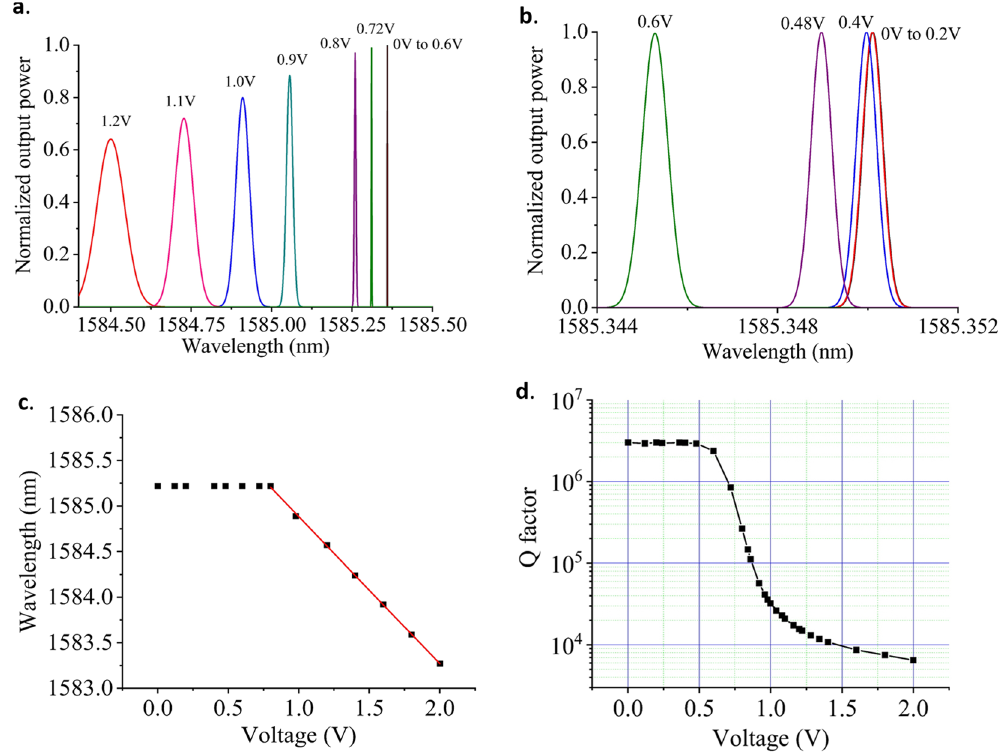
Figure 6. ( a ) Resonant wavelength shift as a function of the applied voltage for a voltage range from 0 to 1.2 V. ( b ) Resonant wavelength shift as a function of the applied voltage for a voltage range from 0 to 0.6 V. ( c ) Resonant wavelength peak position as a function of applied voltage illustrating linear and steep resonant peak shifts for voltages higher than 0.8 V. ( d ) The corresponding quality factor of the resonant wavelength peaks as a function of the applied